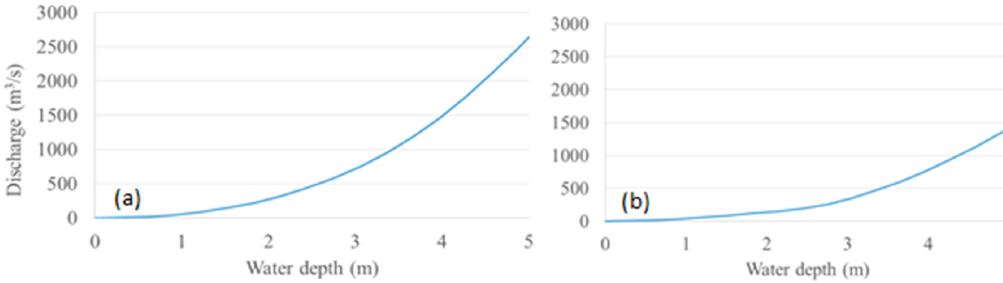
Figure 3. Rating curves created by the Height Above Nearest Drainage (HAND) for ( a ) Squaw Creek River and ( b ) Prairie Creek River.